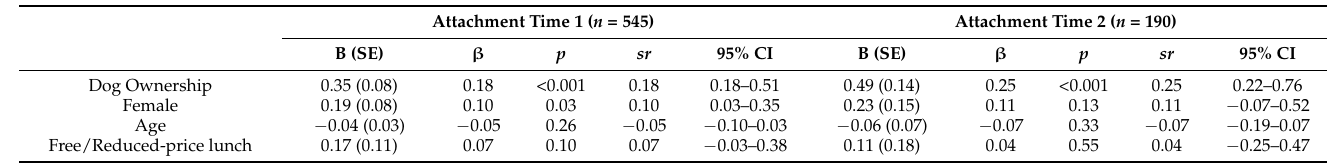
Table 4. Dog ownership (vs. non-dog pet owners) predicting pet attachment at Time 1 (pre-COVID) and Time 2 (dur- ing COVID).